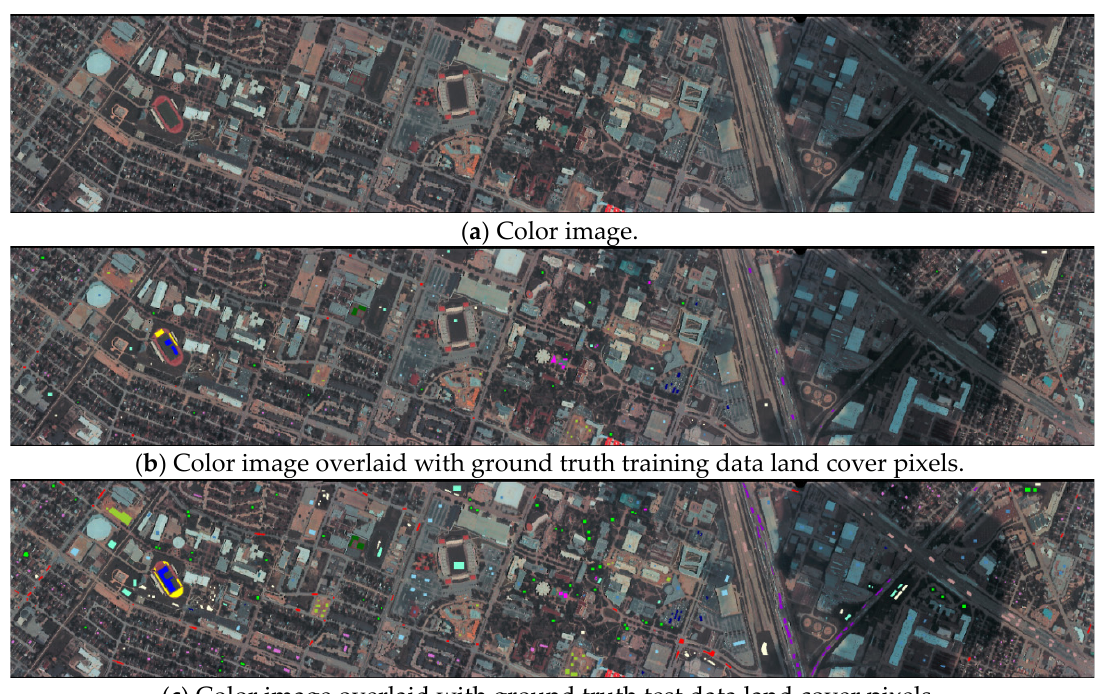
Figure 3. Color image for the University of Houston area with ground truth land cover annotations of test data.